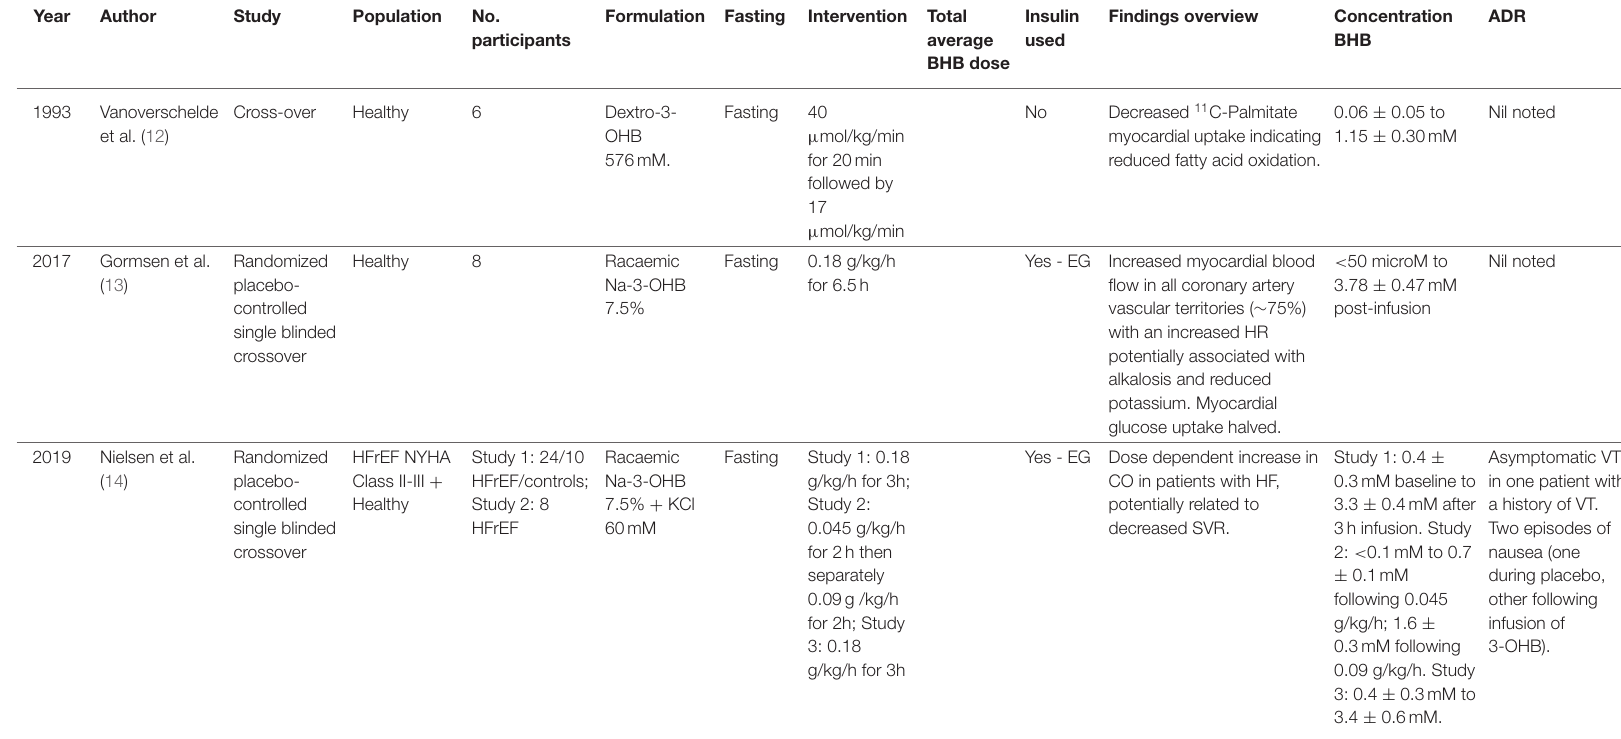
TABLE 1 | Ketone studies investigating cardiac